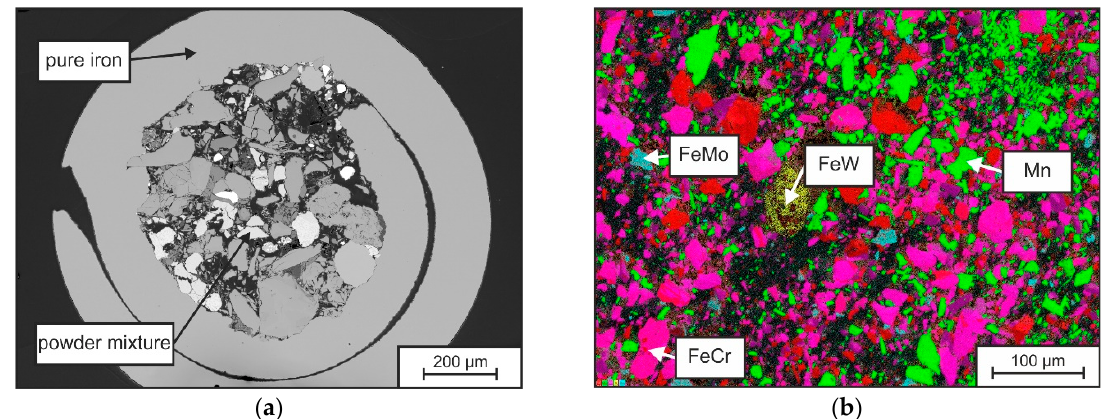
Figure 2. SEM picture of the cross section of the used metal-cored wire ( a ) and element mapping of the contained powder fill ( b ).